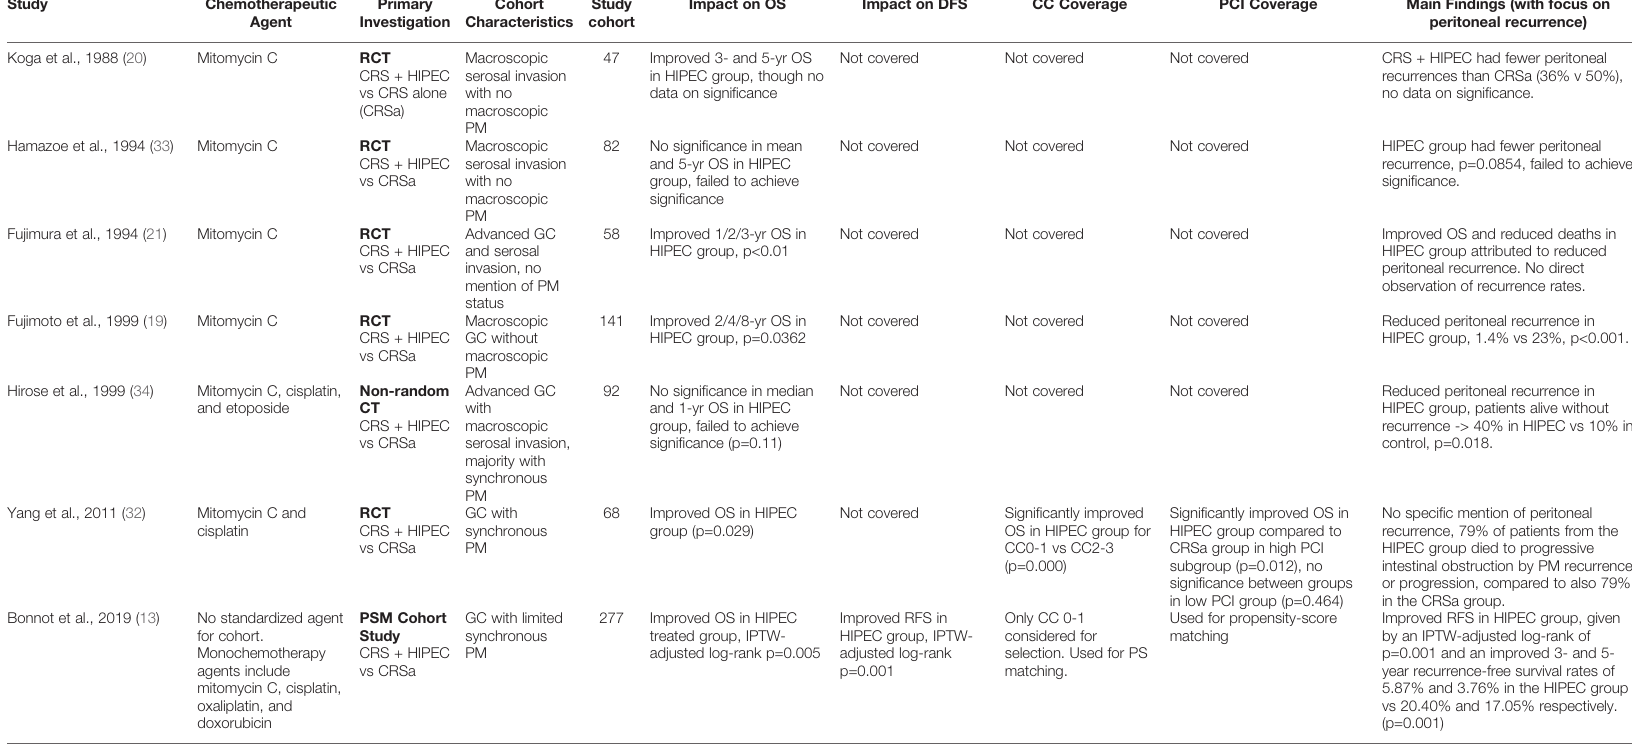
TABLE 2 | Summary of articles on gastric